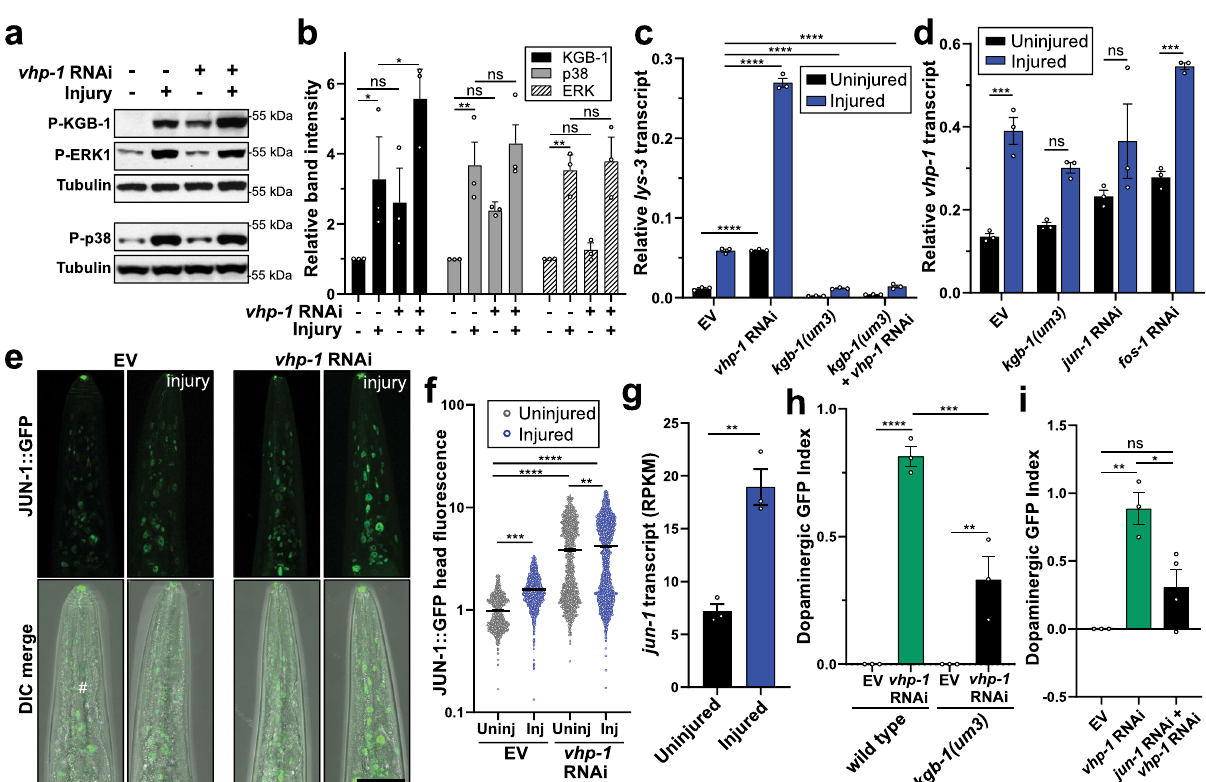
Fig. 6 Bidirectional regulation between VHP-1, KGB-1, and JNK signaling in fl uences neurodegeneration following mechanical stress. a Western blot of phosphorylated (P-) KGB-1, p38, and ERK in response to injury and/or vhp-1 RNAi. Tubulin, loading control. b Quanti fi cation of phospho-speci fi c western blots relative to uninjured empty vector. Mean + SEM. From left to right, ns (not signi fi cant), * p = 0.0116, * p = 0.0109, ** p = 0.0031, ** p = 0.0049 by two-way ANOVA with Tukey test. n = 3 biological replicates. KGB-1 (black), p38 (gray), ERK1/2 (stripes). c , d qPCR of lys-3 or vhp-1 transcript abundance either uninjured (black) or 1h post injury (blue) in wild type or kgb-1(um3) mutants with the respective RNAi. Mean ±SEM. **** p <0.0001, *** p = 0.0004 (EV) and *** p = 0.0002 ( fos-1 RNAi) by two-way ANOVA with Tukey test. n = 3 biological replicates. e Confocal micrographs of JUN-1::GFP expression in the worm head with and without vhp-1 RNAi and injury (4h post trauma). Differential interference contrast, DIC. Reference Fig. 6f. Scale = 50 µ m. f Quanti fi cation of JUN-1::GFP by large-particle fl ow cytometry comparing fl uorescence in the worm head for uninjured (Uninj, gray) and 4 h post injury (Inj, blue) with and without vhp-1 RNAi. Mean ±SEM. Two-way ANOVA with Tukey multiple comparison test. See Supplementary Data 5 for statistics. g JUN-1 transcript abundance determined by RNAseq without injury (black) and 1h post injury (blue). Mean± SEM. ** p = 0.003 by two-sided unpaired t -test. n = 3 biological replicates. Reads per kilobase million (RPKM). h , i Large-particle fl ow cytometry showing the effects of trauma on dopaminergic GFP retention 48h post injury. Shown are values indexed to empty vector control (EV). Mean ±SEM. h vhp-1 RNAi in wild type (green) or kgb-1(um3) mutants (black). i effects of jun-1 RNAi with vhp-1 RNAi (black) compared to vhp-1 RNAi alone (green). Positive values indicate reduced loss of fl uorescence when compared to age-matched uninjured controls. A value of one indicates no change of fl uorescence compared to uninjured controls. See Supplementary Data 5 for